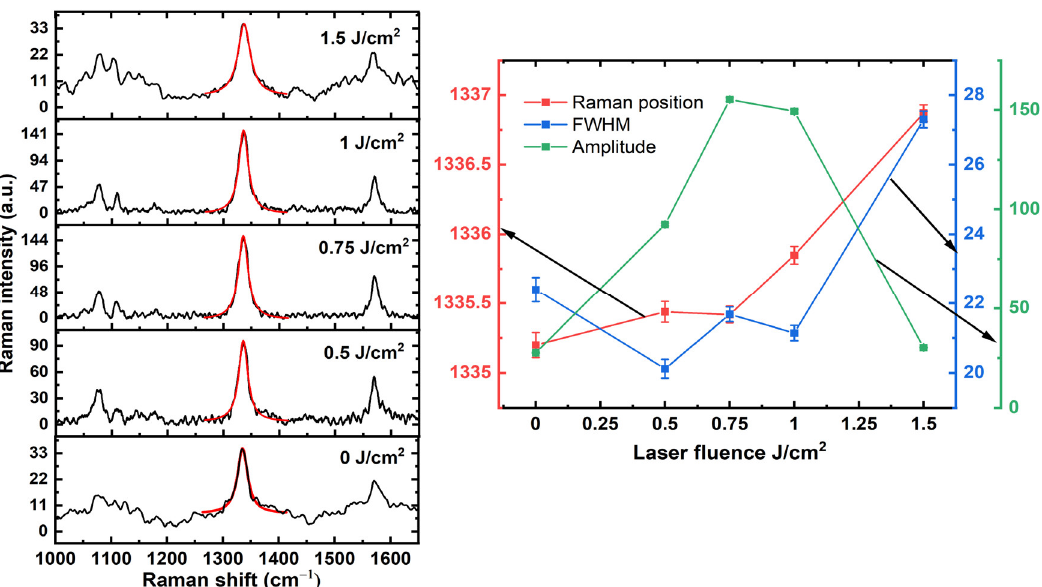
Figure 5. On the ( left ): Raman spectra taken from different areas of Au-Pd with a thickness 48.6 nm irradiated with various laser fluence values (0 J/cm 2 , 0.5 J/cm 2 , 0.75 J/cm 2 , 1 J/cm 2 and 1.5 J/cm 2 ), and the peak located at 1340 cm − 1 adjusted with a Lorentzian function (red curve); on the ( right ): extracted parameters (Amplitude, Raman peak position, FWHM) from the adjustment with the Lorentzian function versus laser